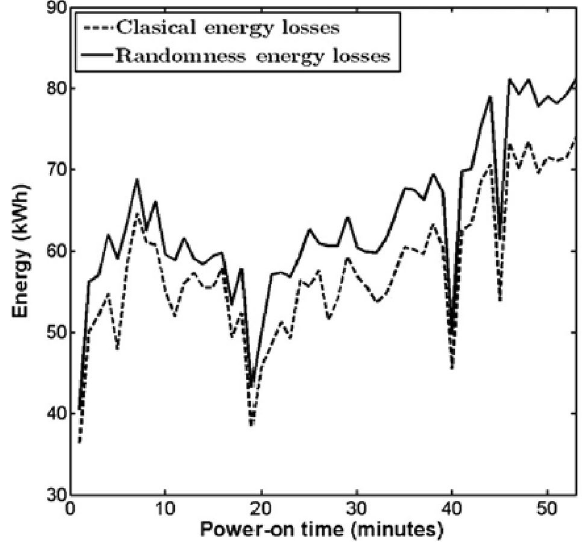
Fig. 17 Estimated energy losses in the EAF shell with the on-time [16]